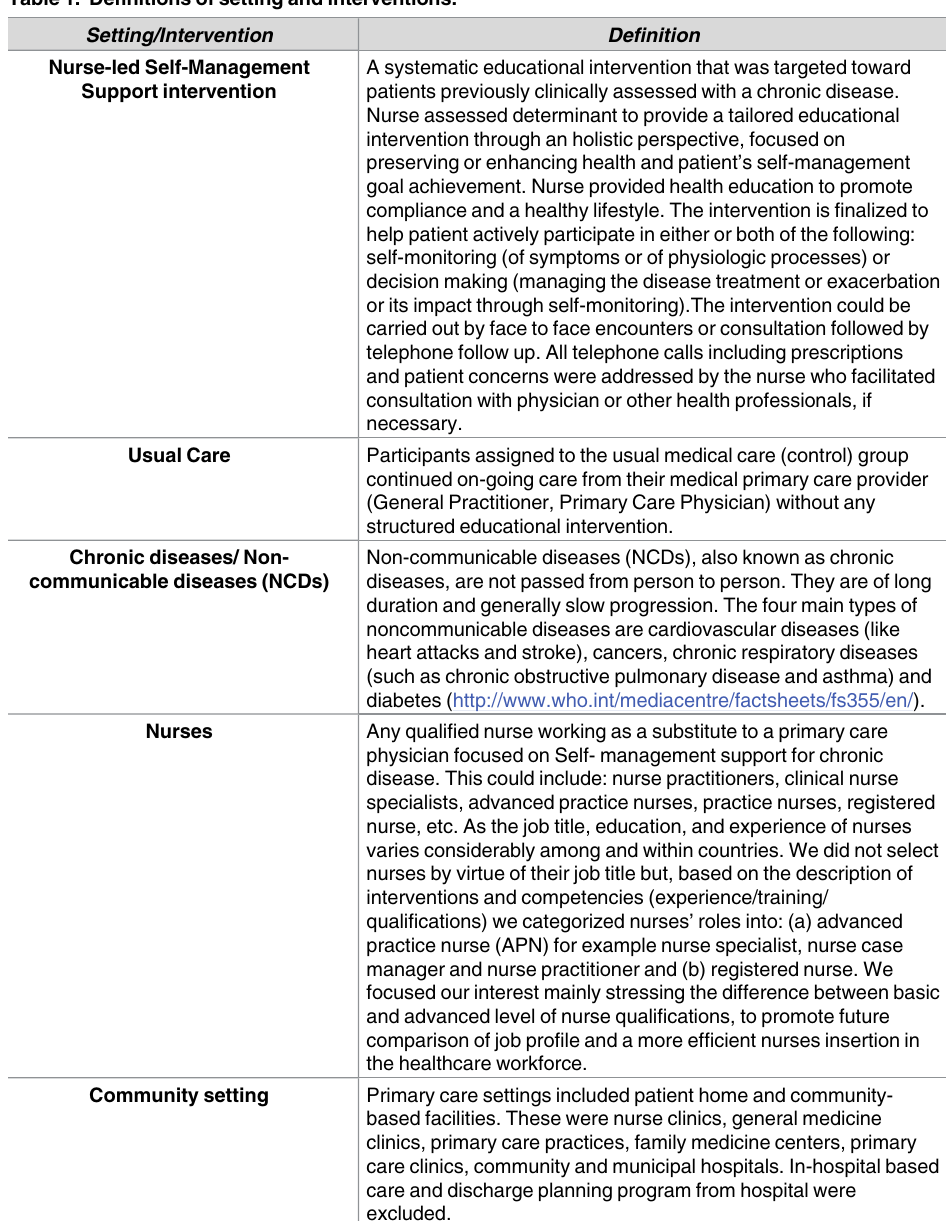
Table 1. Definitions of setting and